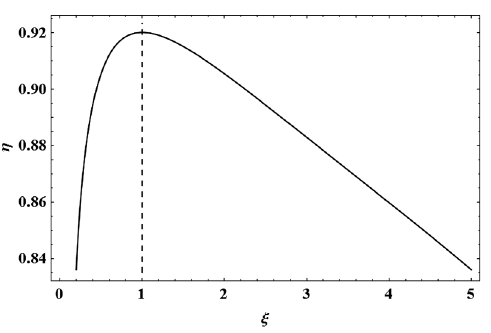
FIG. 7. The relative contribution of power, formed by the second pulse in the total output power depending on the parameter ς